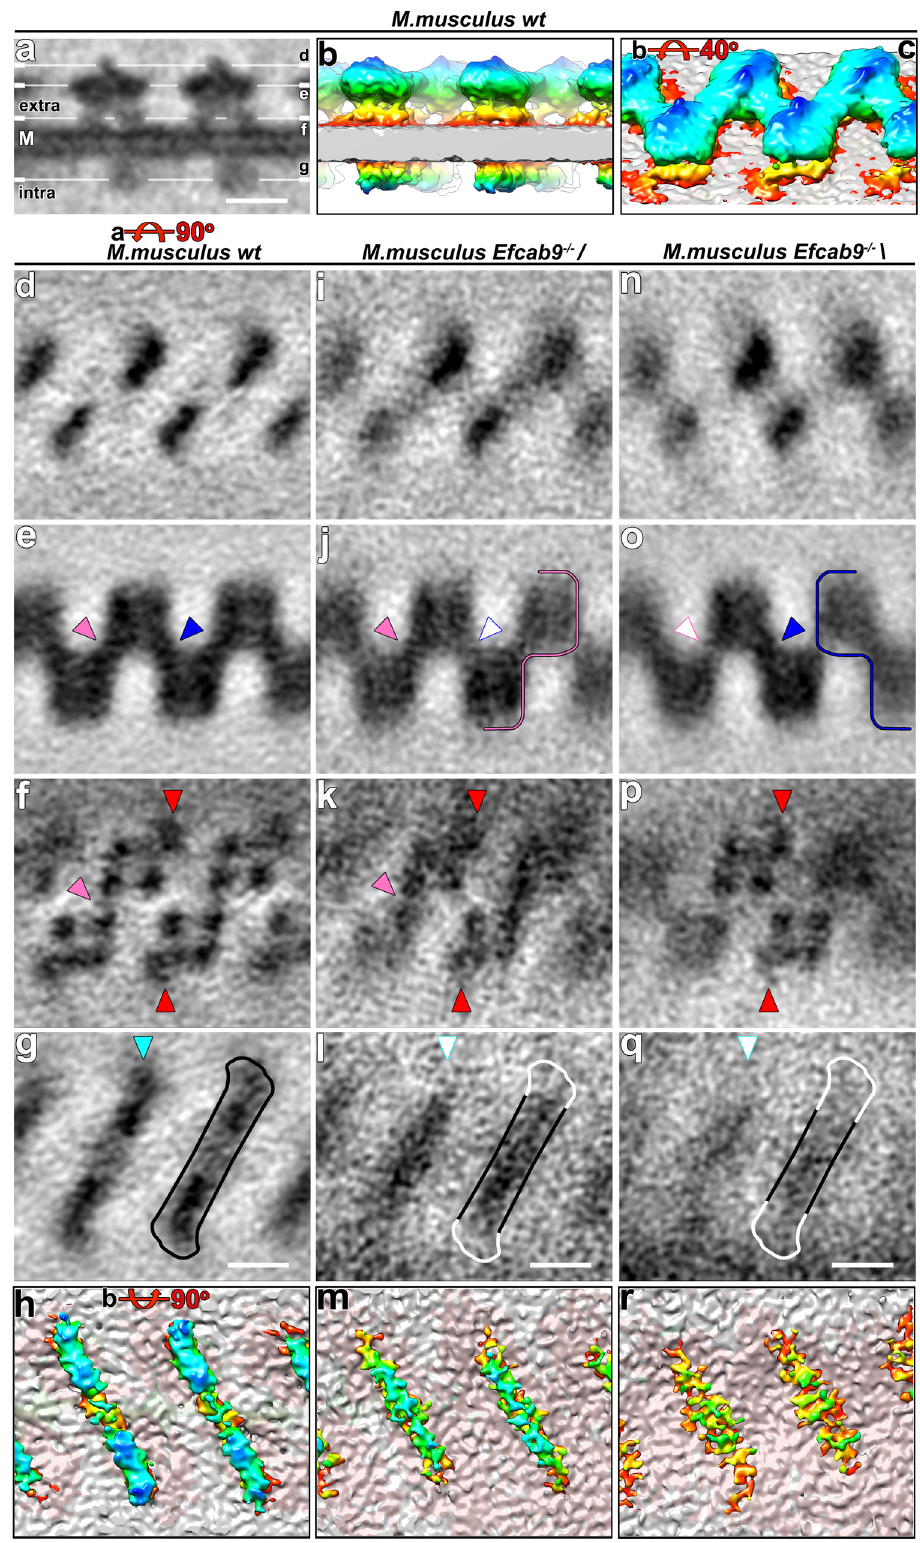
cryo-FIB milled lamella of sperm fl agella (Supplementary Table 2). To ensure that only CatSper complexes were included during the averaging process, we picked particles only from assemblies con- taining 3 + subunits in a zigzag arrangement, and excluded any scattered individual particles as these could not be unambiguously identi fi ed as CatSper complex. The mutant averages showed